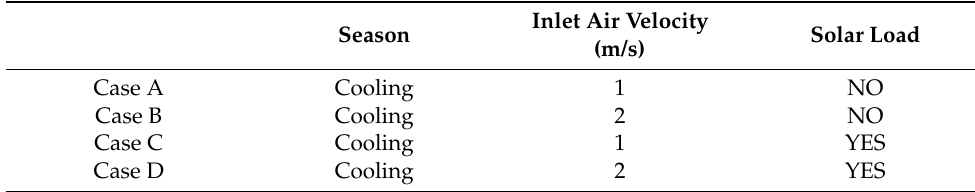
Table 1. Summary of the studied configurations in summer-cooling